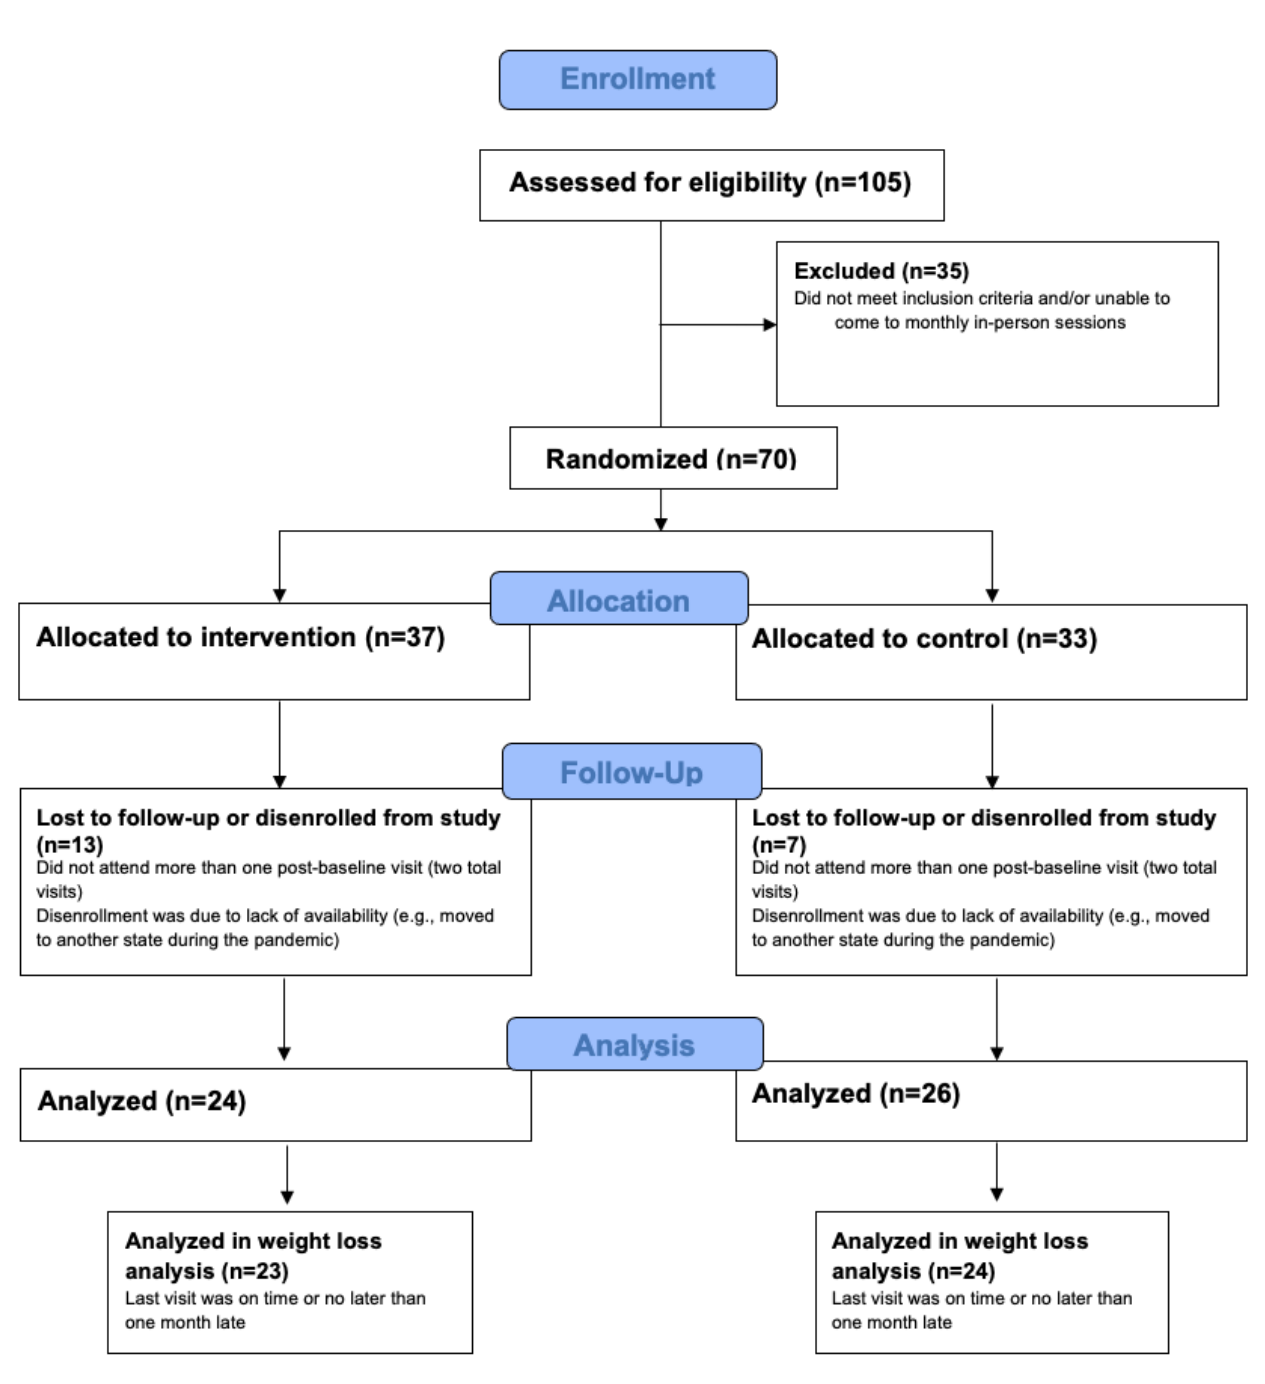
Figure 1. Flow diagram of inclusion and